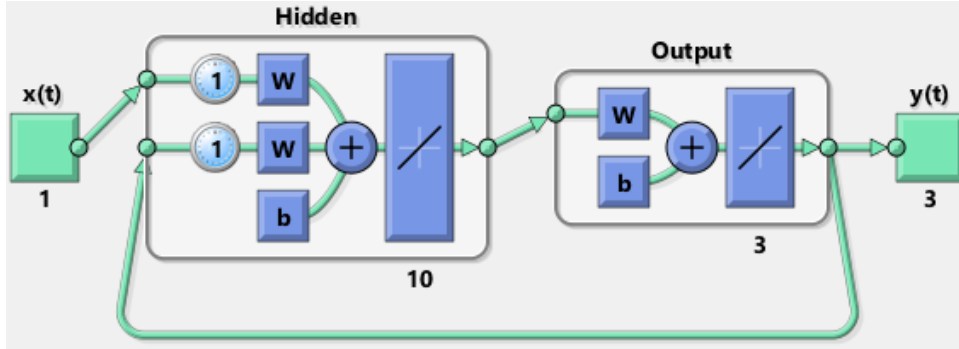
Figure 1. Initial structure from which the architecture of the NARXs was developed.